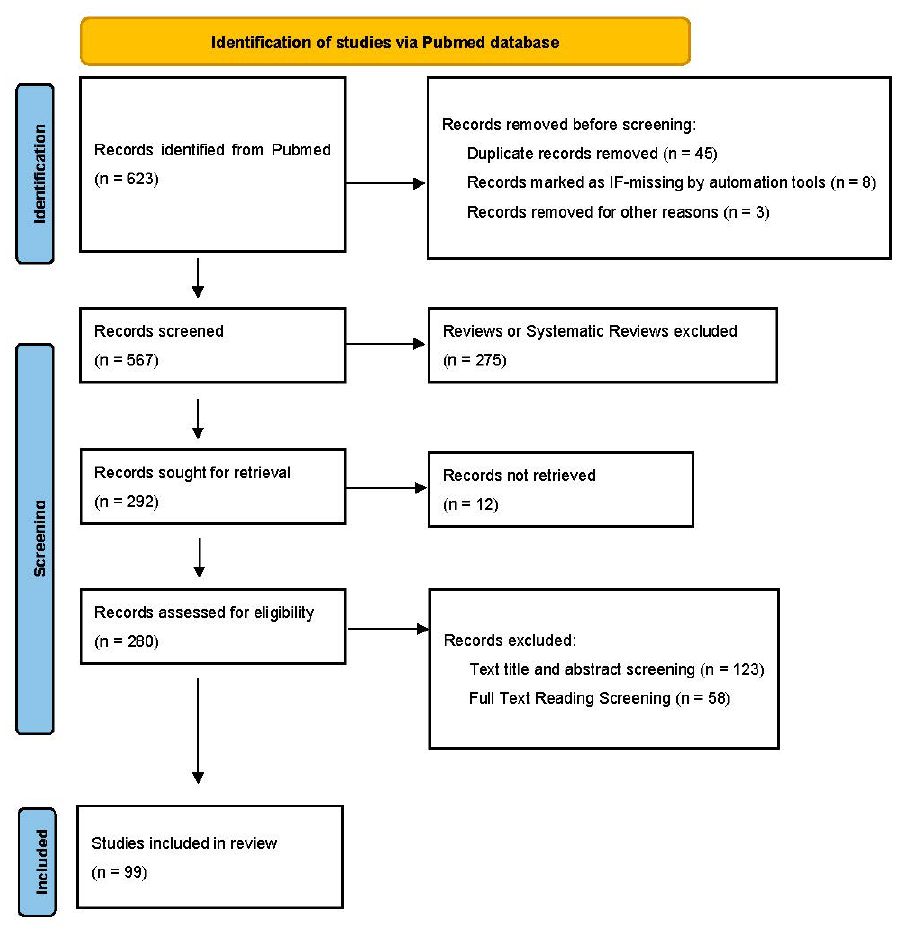
Figure 2. PRISMA workflow for review, which illustrates the relationship between intestinal mi- crobes and chronic liver